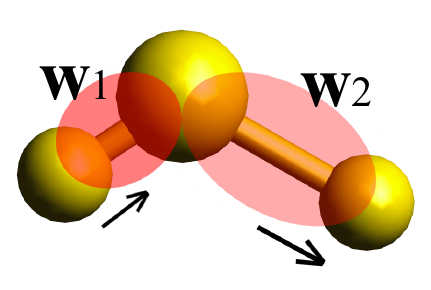
Figure 1. Schematic view of an asymmetric stretching mode of a molecule. Wannier functions w 1 and w 2 , centered along two adjacent covalent bonds, are also